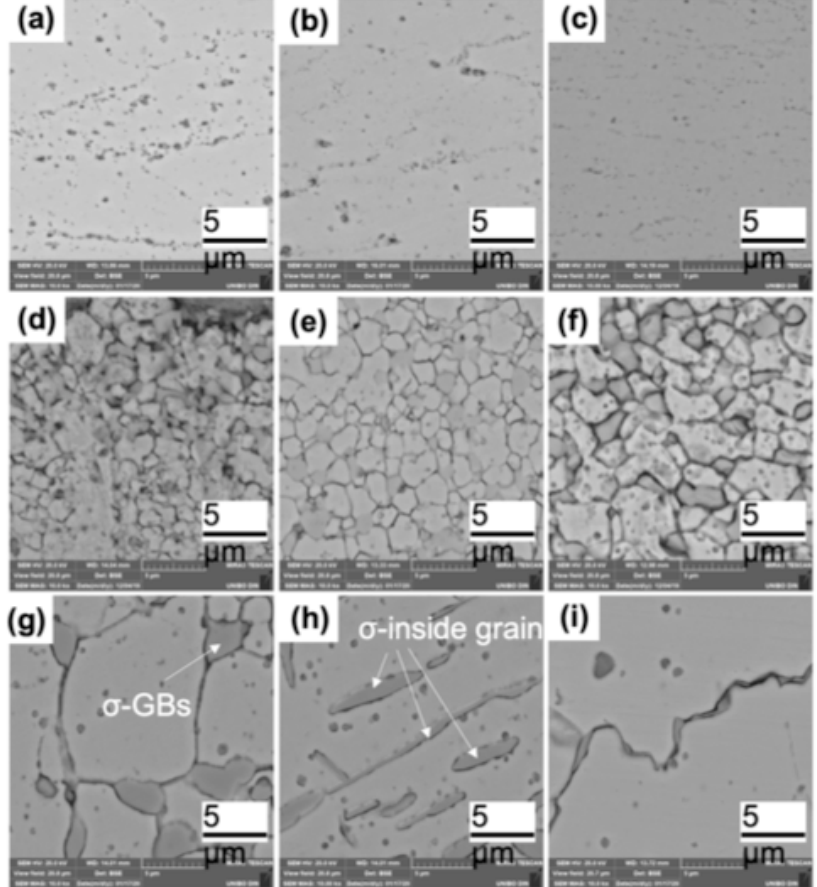
Figure 7. SEM-FEG transversal section microstructures of cold-rolled ( a ) and cold-rolled plus annealed samples (from ( b – i )). Annealing temperatures are: 723 K ( b ), 823 K ( c ), 923 K ( d ), 1023 K ( e ), 1103 K ( f ), 1223 K ( g ), 1323 K ( h ), 1423 K ( i ).